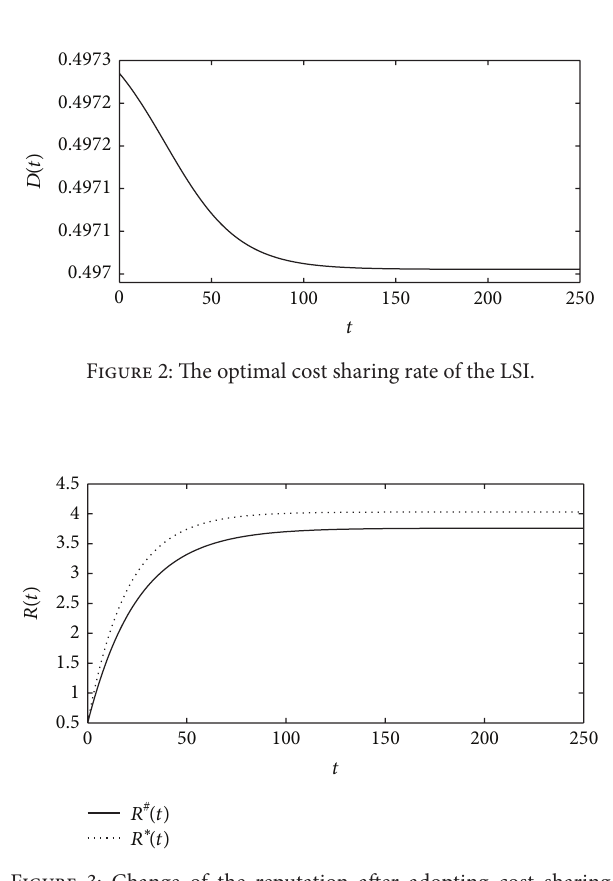
Figure 3: Change of the reputation after adopting cost sharing contract.